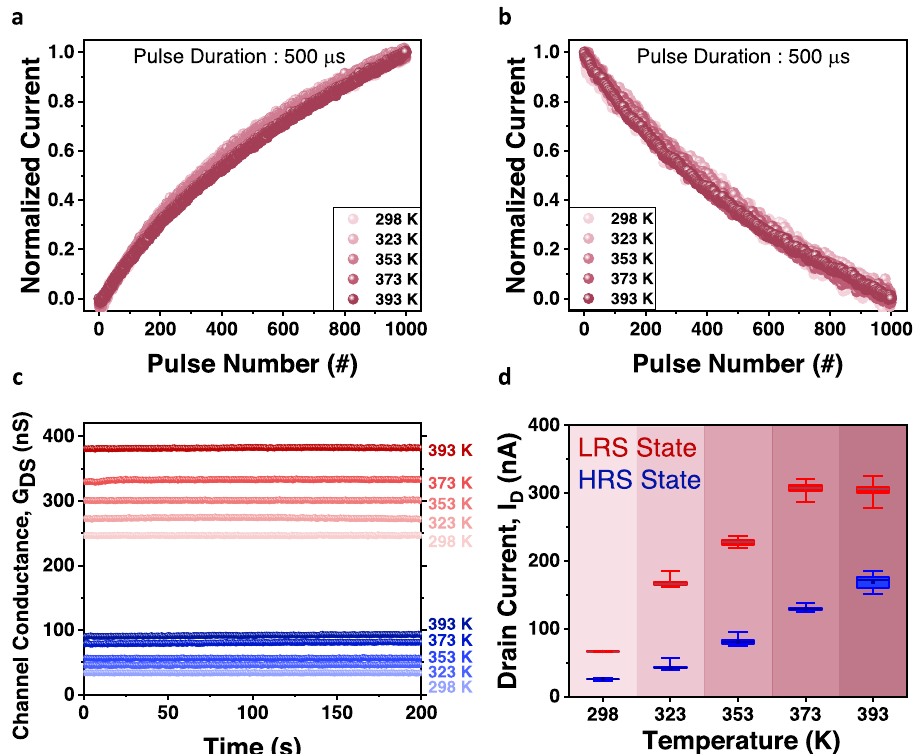
Fig.4|RobustnessoftheGIFETtotemperaturevariations. Linearityvariationin various temperatures from 298K to 393K with a 1000 potentiation pulses (4V, 500 μ s) and b 1000 depression pulses ( − 4 V, 500 μ s). c Measurement of retention characteristics of two conductance states at various temperatures from 298K to 393K.Erasepulses( − 3.3V,500 μ s)of100(redsphere)and1000(bluesphere)were